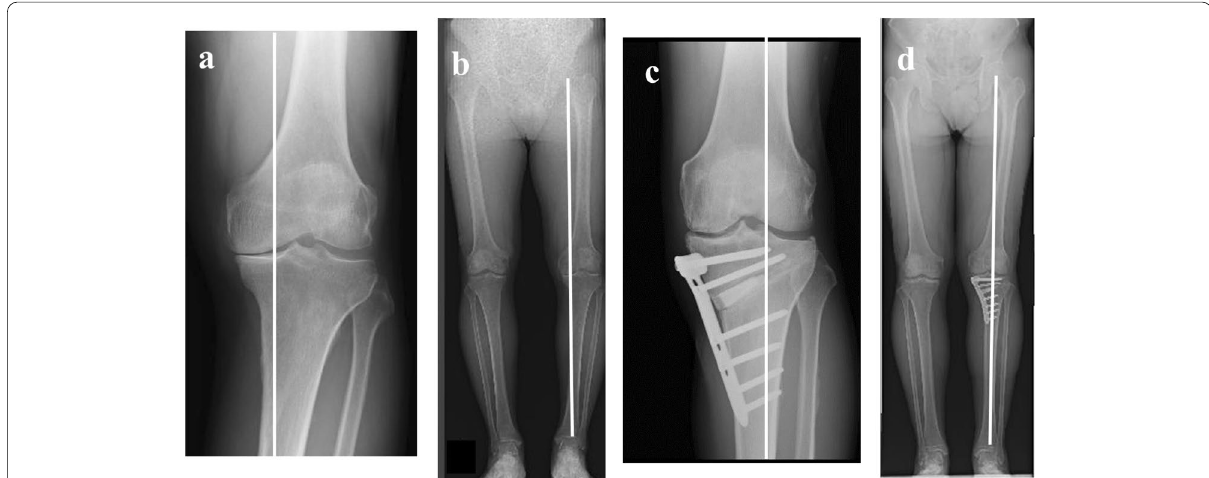
Fig. 2 a , b Preoperative radiographs showing varus correction: the mechanical axis passes through 35.1% and the FTA is 181° in the left leg. c , d Postoperative radiographs showing that the mechanical axis passes through 62.1% and the FTA is 171° in the left leg